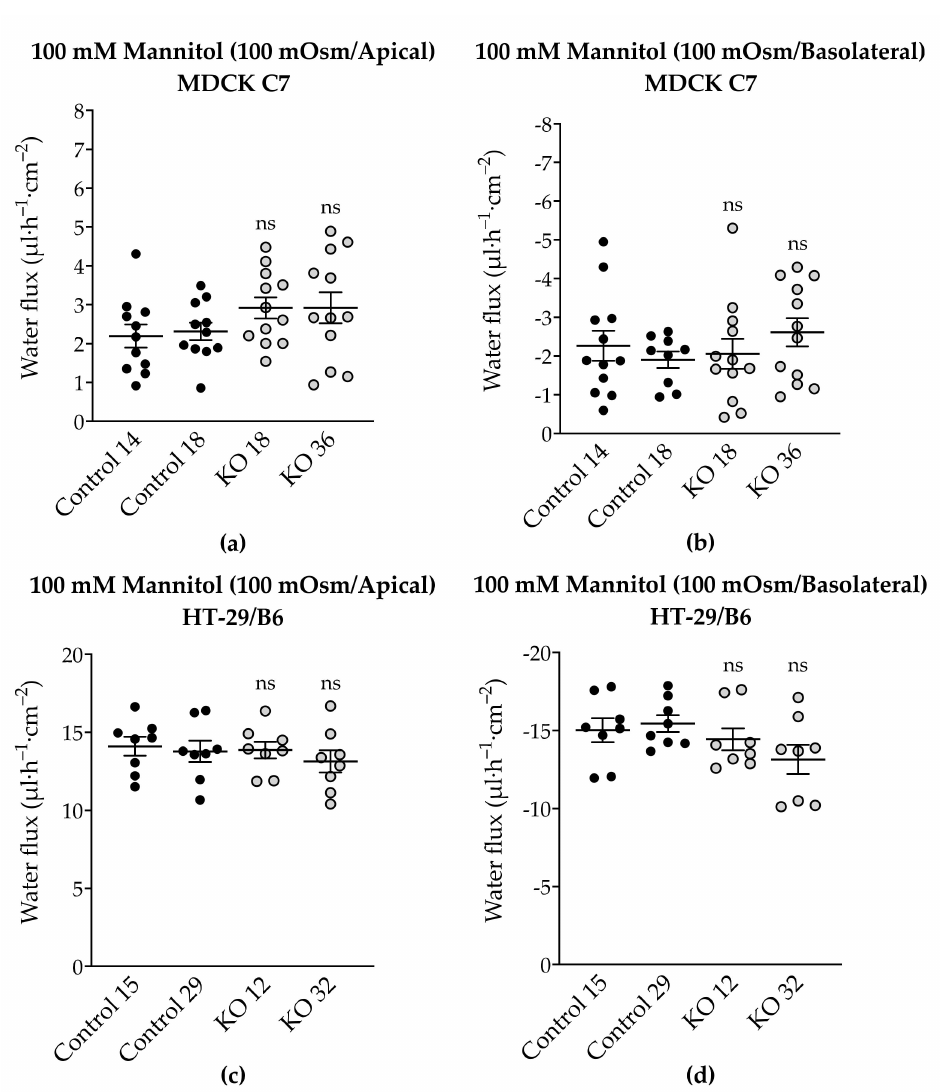
Figure 7. Water flux in control and angulin-1 knockout cells stimulated by an osmotic gradient on the apical or the basolateral side. Water flux induced by a gradient of 100 mM mannitol in ( a , b ) MDCK C7 and in ( c , d ) HT-29/B6 cells was unchanged. Statistical analysis was performed using one-way ANOVA test was used to compare between the four clones in both cell lines (ns: not